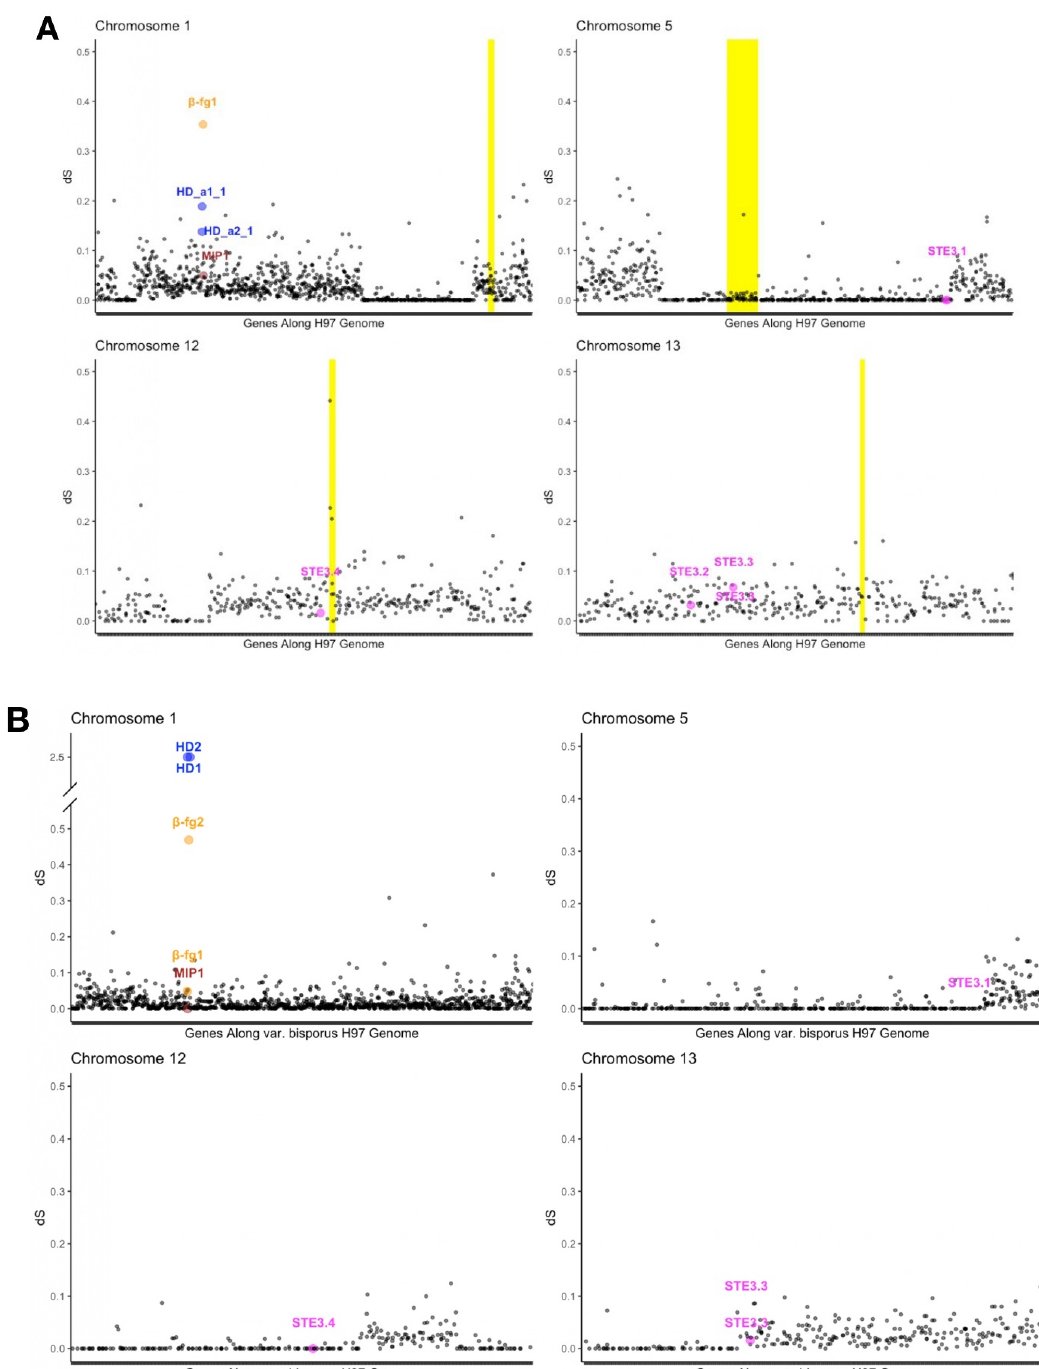
Figure 8. Synonymous substitution rates between the homokaryotic genomes of A. bisporus var. bisporus H97 and H39 ( A ) and between A. bisporus var. burnettii H119p1 and H119p4 ( B ). The Y-axis shows the synonymous divergence levels between the alleles found in the homokaryotic genomes of H97 and H39 of alternative mating types, issued from the U1 cultivar. The X-axis shows the gene order along the H97 genome. Yellow highlights on the background show the putative centromeric regions. Genes found in and around the mating-type loci are highlighted with different colours (blue for HD genes, orange for β -fg1 gene, brown for mip1 gene and magenta for STE3 -like putative pheromone receptor genes). Other chromosomes are shown in Supplementary Figure S2.